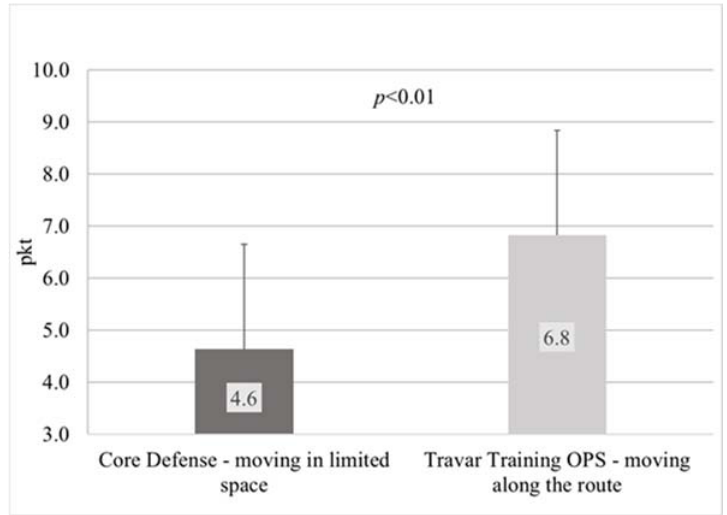
Figure 7. Rating of perceived exertion (10-degree scale) in obese children during PA in IVR on an omnidirectional treadmill depending on the type of video game.